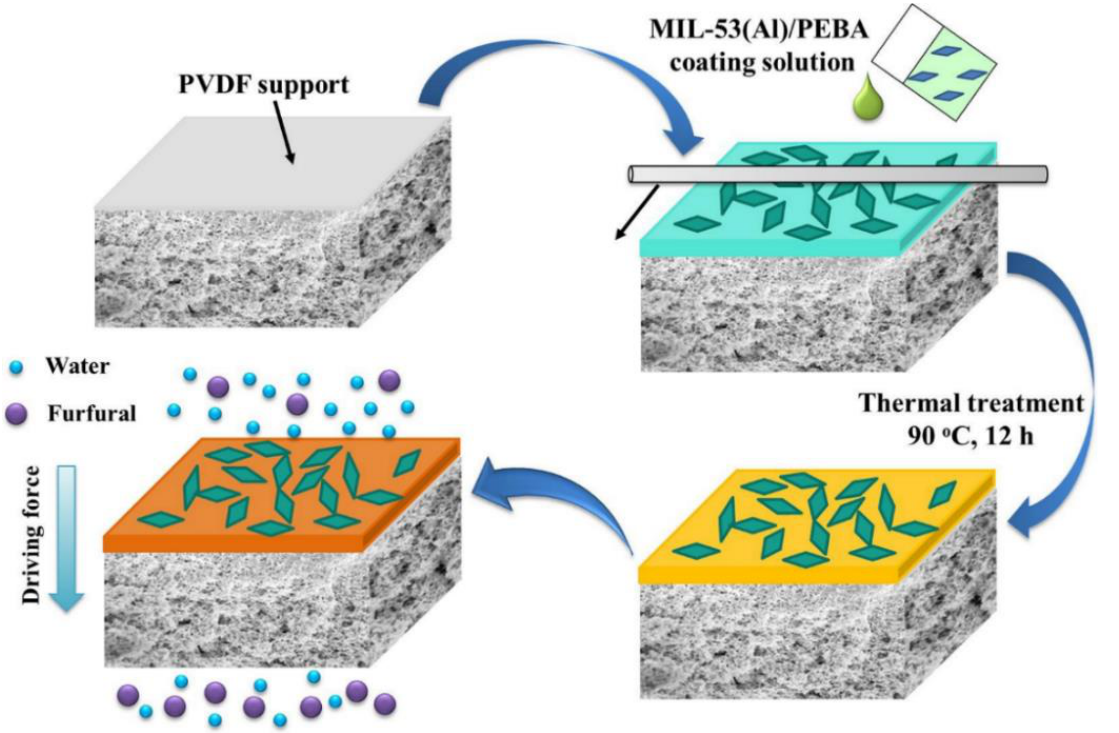
Figure 5. MMMs incorporating MIL-53(Al) MOFs, synthesised by microwave with a coin-like mor- phology, for furfural/water separation (from ref. [38]). morphology, for furfural/water separation (from ref.